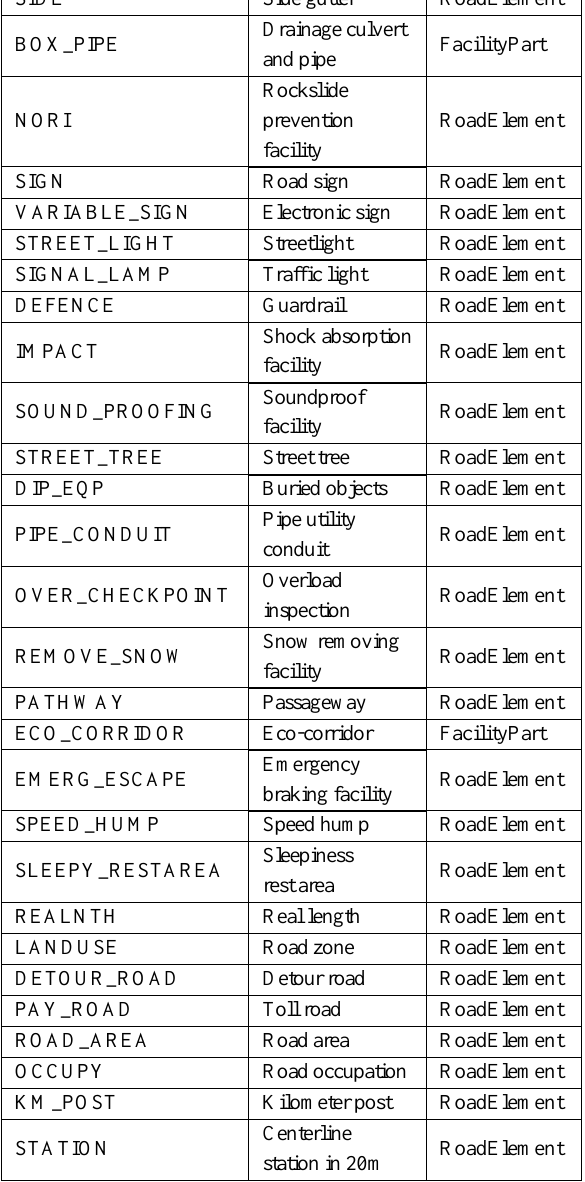
Table 1. Corresponding classes between the road register and LandInfra